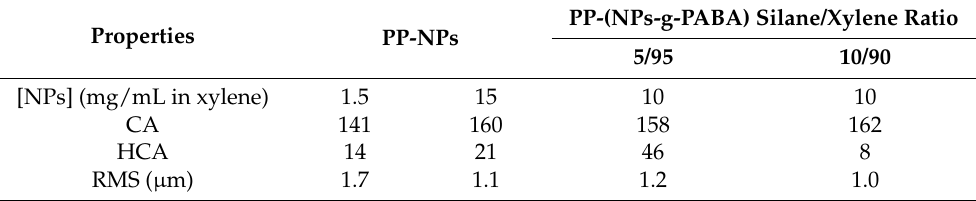
Table 1. Comparative properties between PP surfaces nanostructured with TiO 2 NPs with and without chemical modification by dendronization.